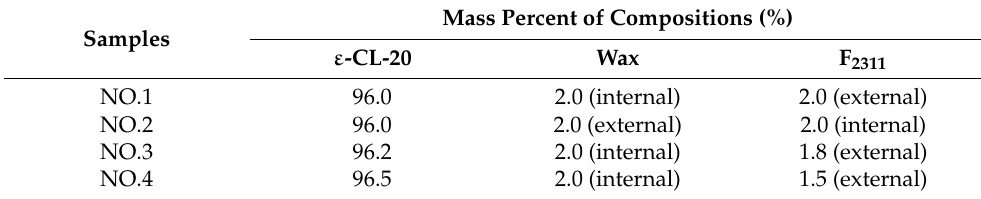
Table 1. Formulations of composites with different